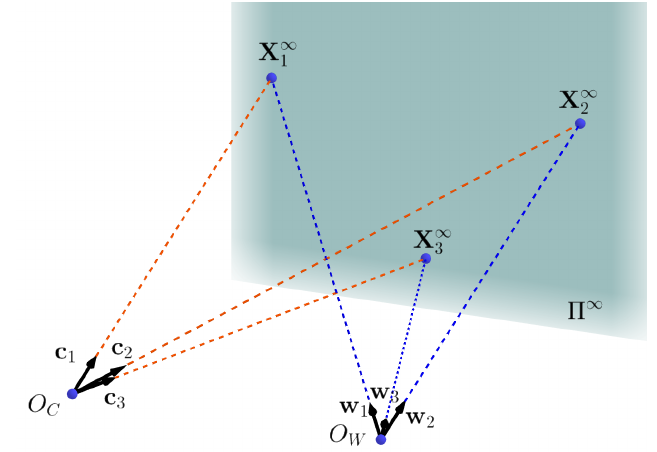
Figure 5. Geometric relationship between two coordinate systems. O C is the origin of the camera coordinate system. O W is the origin of LiDAR coordinate system. Π ∞ is the infinity plane in the space. X ∞ , X ∞ , and X ∞ are 3D infinity points in the world coordinate system. Actually, c i and w i coincide in 2 3 1 the